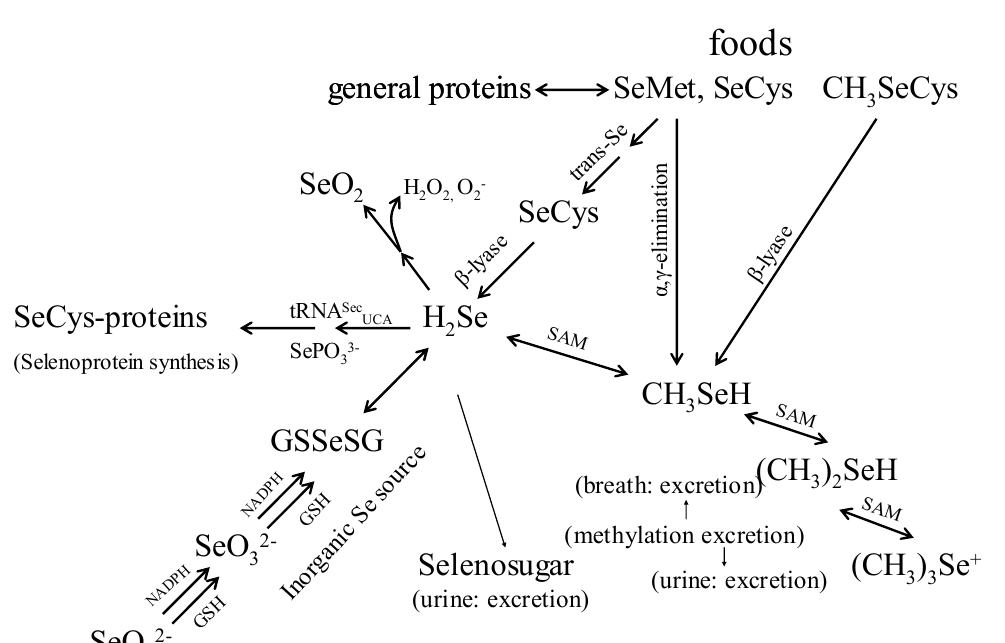
Figure 1. Proposed pathways for the metabolism of biologically important selenomolecules (Adapted from